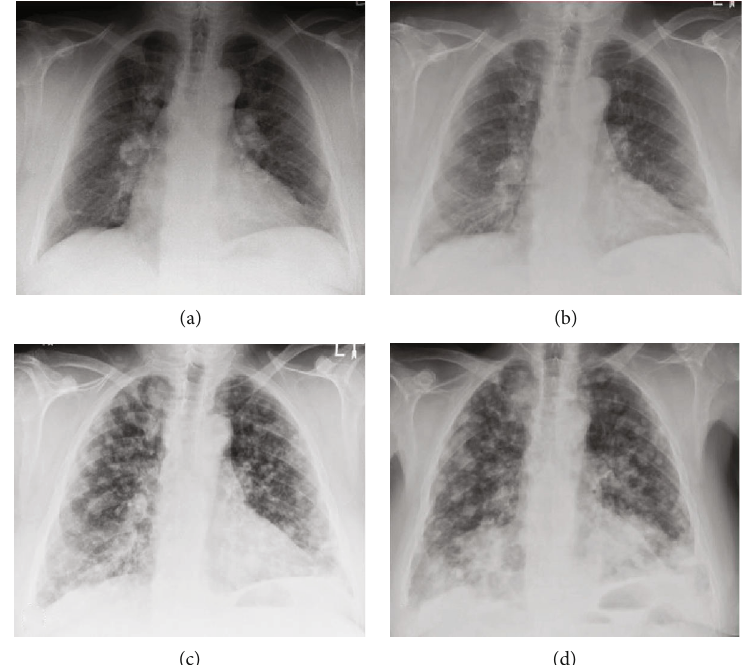
Figure 2: Chest radiographs of Patient 3 showing slow progression of metastatic nodules at two years (a), fi ve years (b), seven years (c), and 10 years (d) of